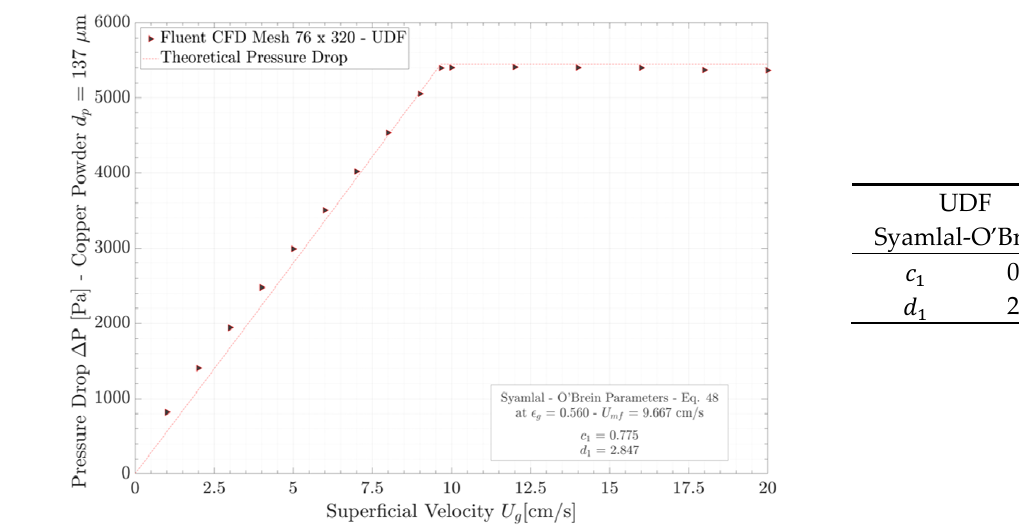
Figure 7. Schematic representation of the cold model used to investigate the hydrodynamic behavior of the ENEA’s ICBFB reactor. In the table, characterizing properties of solid particles composing the inert bed material and fluidizing condition for the two chambers are collected.